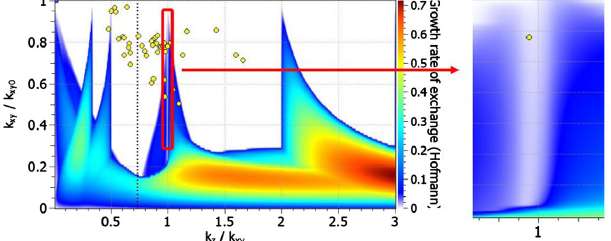
FIG. 40. Stability chart representing the second, third, and fourth-order resonances in the linac overlapped with the period operating points.